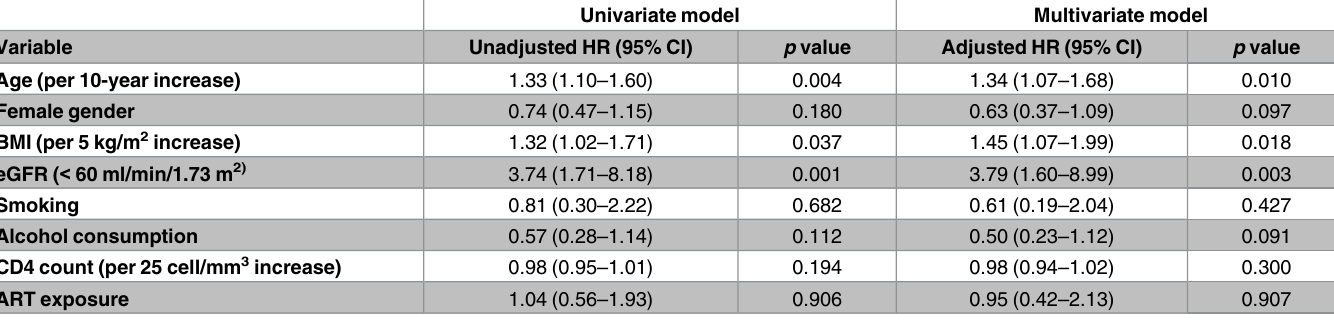
Table 3. Cox regression analysis of risk factors for hypertension development.